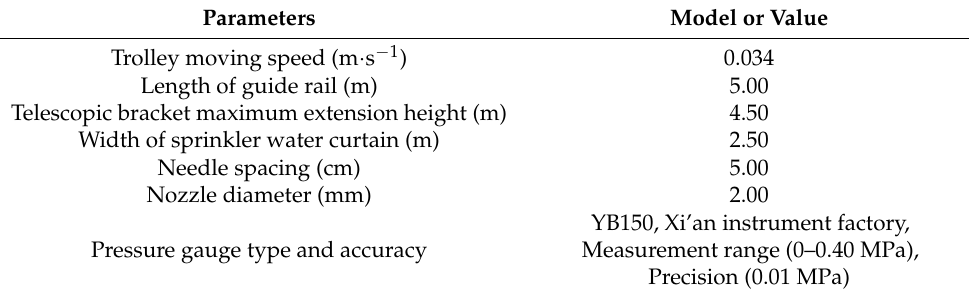
Figure 1. Regulation and controlling device of sprinkler irrigation droplets landing angle. ( a ) shows the overall structure of the device; ( b ) shows the working situation of the device. Table 1. Structure parameters of the regulation and controlling device of the droplet landing angle. Parameters Model or